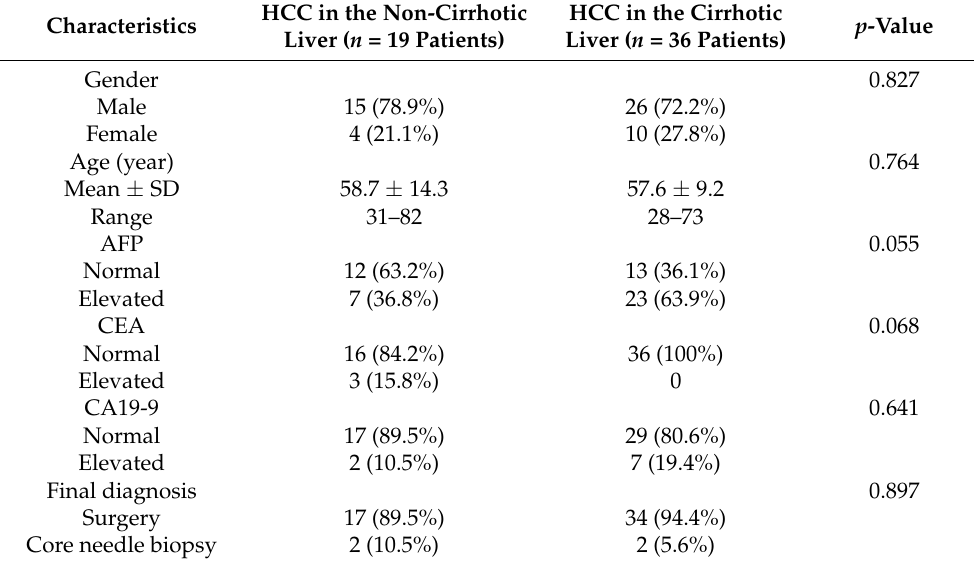
Table 1. Base characteristics of patients.